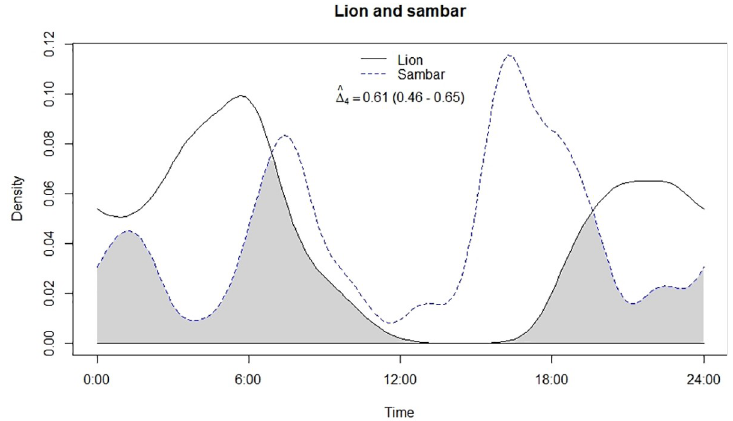
Fig 7. Temporal overlap between lion and sambar.